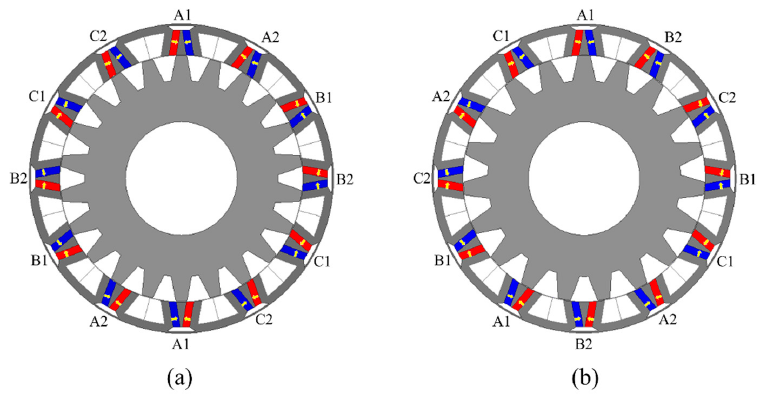
Figure 1. ( a ) The initial and ( b ) the optimal structures of 6-phase V-shaped FSPM generators.